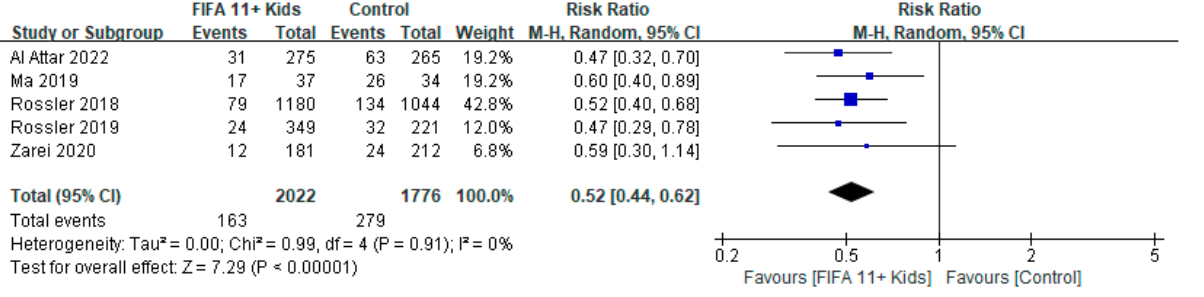
Figure 2. Primary analysis of overall injury rates in the “FIFA 11+ Kids” program compared with control intervention on overall number of injuries [16,17,27,29,30].